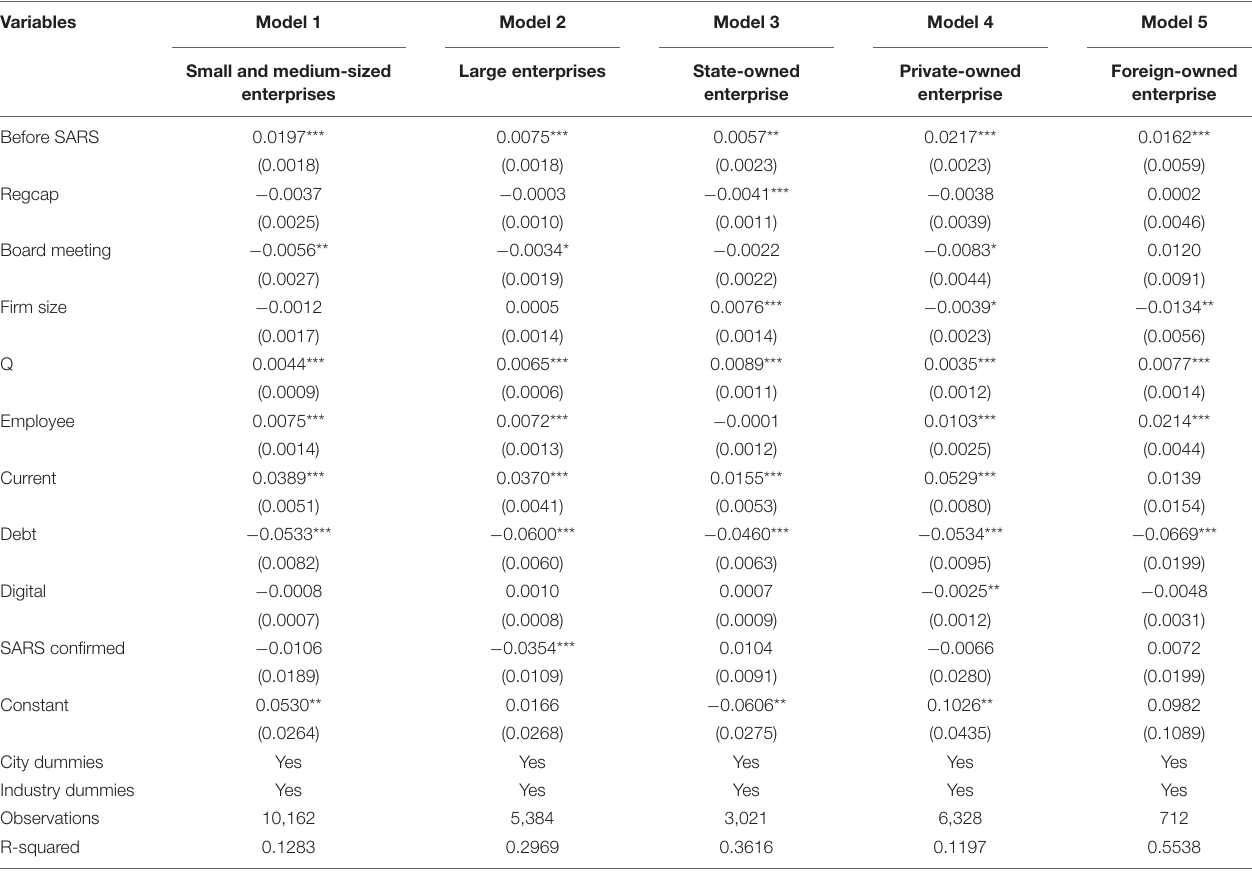
TABLE 6 | The impact of SARS imprint on the recovery of different types of